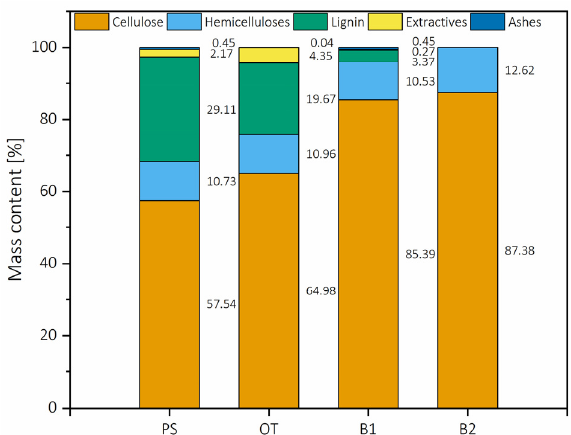
Figure 1. Composition of the pistachio shells through the different processes. PS is pistachio shells, OT is after organosolv treatment, B1 is after the first beaching, and B2 is after the second bleach-